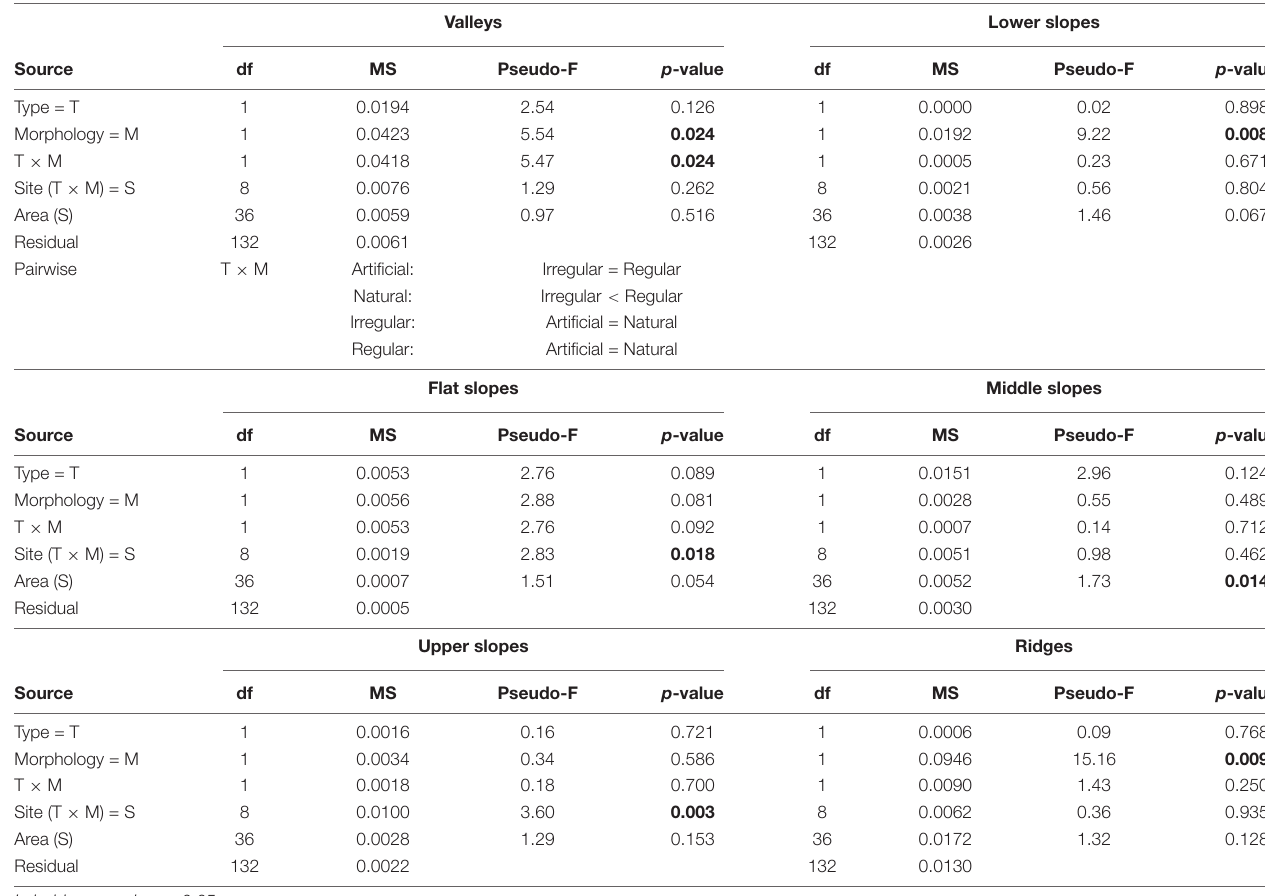
TABLE 2 | Four-way PERMANOVA results testing the effects on the abundances of six morphological microelement (valleys, lower slopes, flat slopes, middle slopes, upper slopes, ridges). Valleys Lower